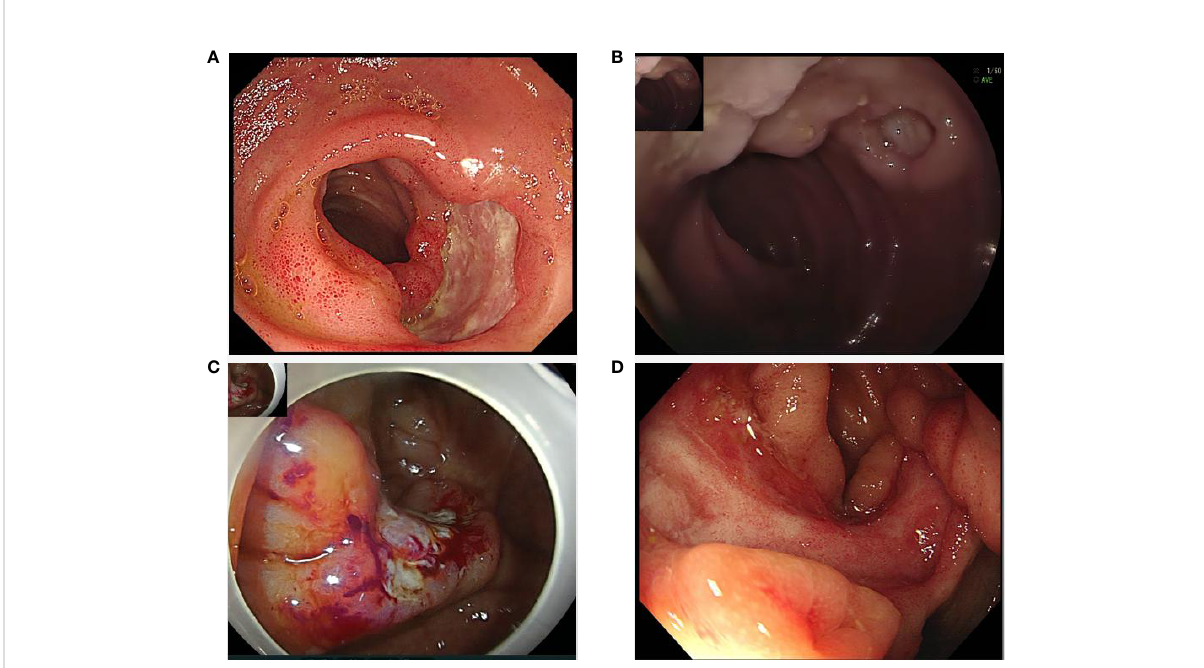
FIGURE 1 Intestinal ulcers in four patients with intestinal Behc ̧ et ’ s Syndrome before tofacitinib administration: (A) Ileocecal ulcer in case 1; (B) Ileum ulcer in case 2; (C) Ileocecal ulcer in case 3; (D) Ileocecal ulcer in case